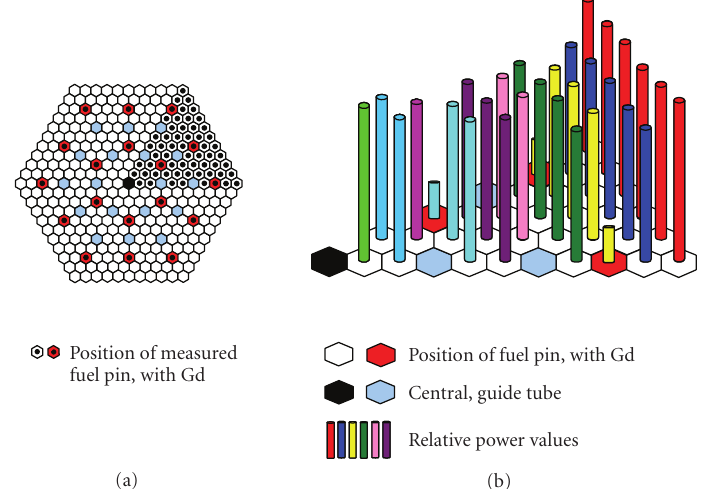
Figure 2: (a) Positions of measured FPs in CFA and (b) power distribution in the 30-degree symmetry sector of the CFA with 3Gd FPs.